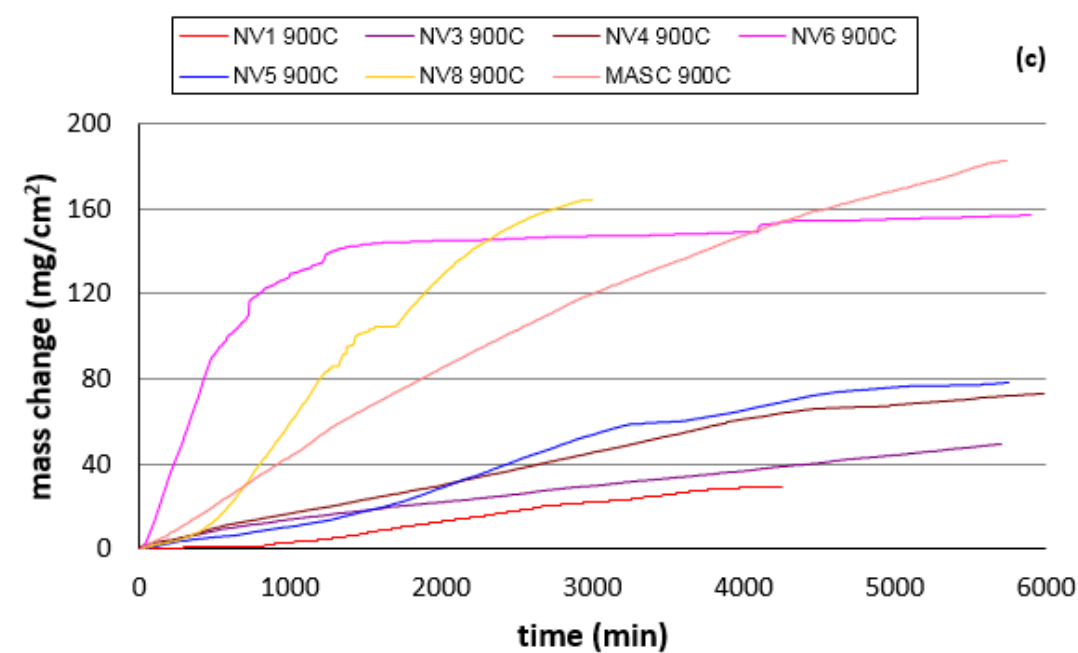
Figure 4. Mass change versus time of the alloys NV1, NV3, NV4, NV5, NV6, and NV8 at ( a ) 700 °C, ( b ) 800 °C, and ( c ) 900 °C. Ranking of alloys from best to worst oxidation in ( a ) NV4, NV5, NV8, NV6, NV3, NV1, and MASC; ( b ) NV5, NV8, NV4, NV1, NV6, MASC, and NV3; and ( c ) NV1, NV3, NV4, NV5, NV6, MASC, and NV8.